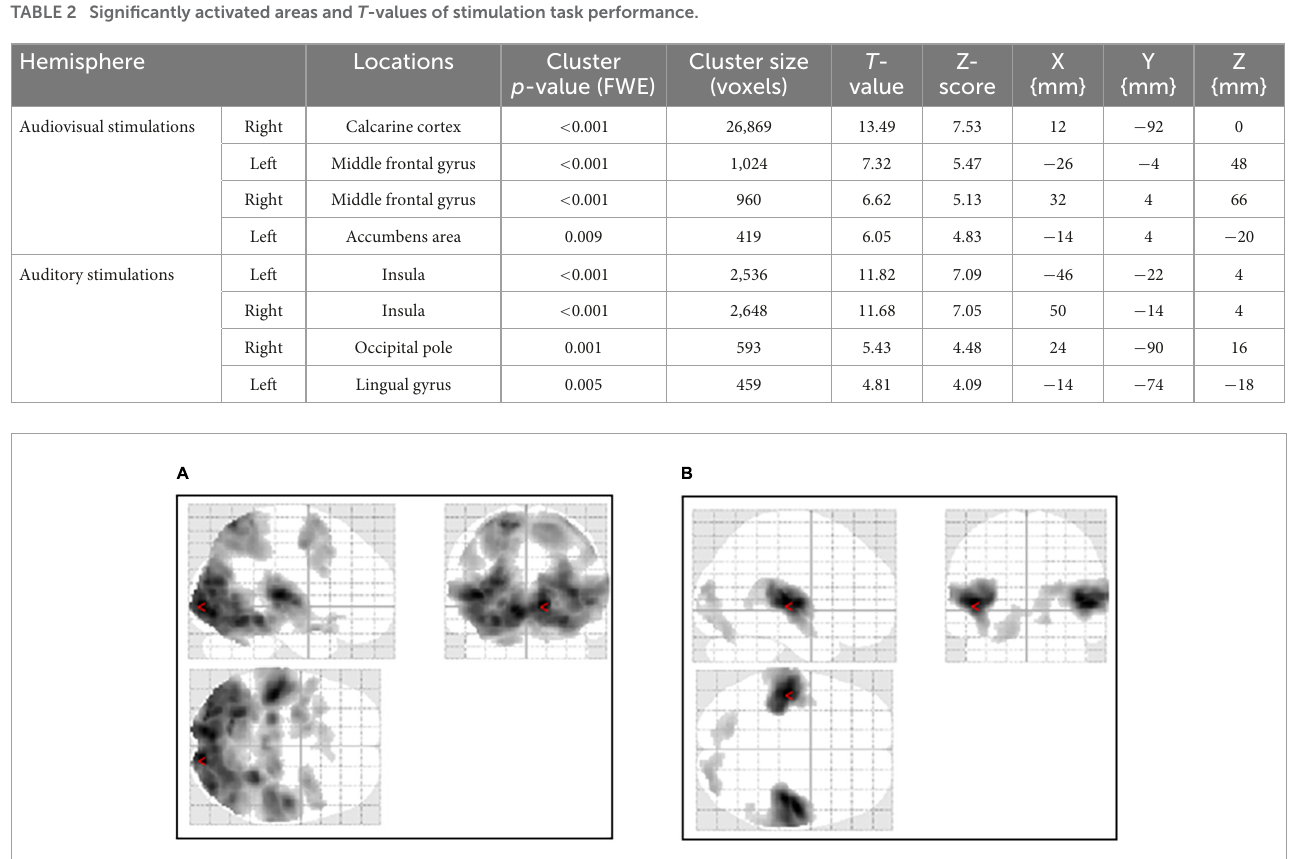
FIGURE2 Activation of the whole brain during the stimulation task. (A) Activation during the ASMR audiovisual stimulation task. (B) Activation during the ASMR auditory stimulation